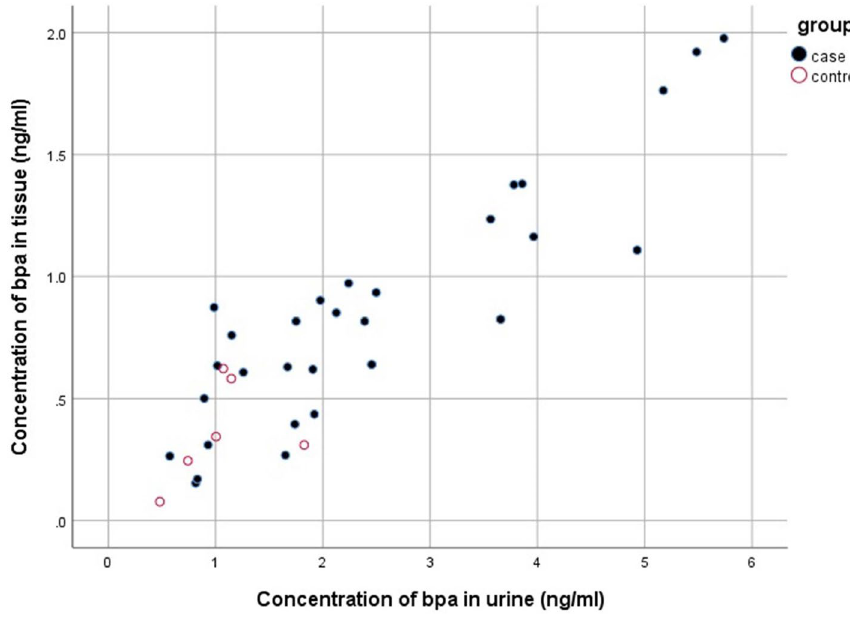
Figure 1. Correlation of BPA concentrations in urine with adipose tissue in case and control groups.